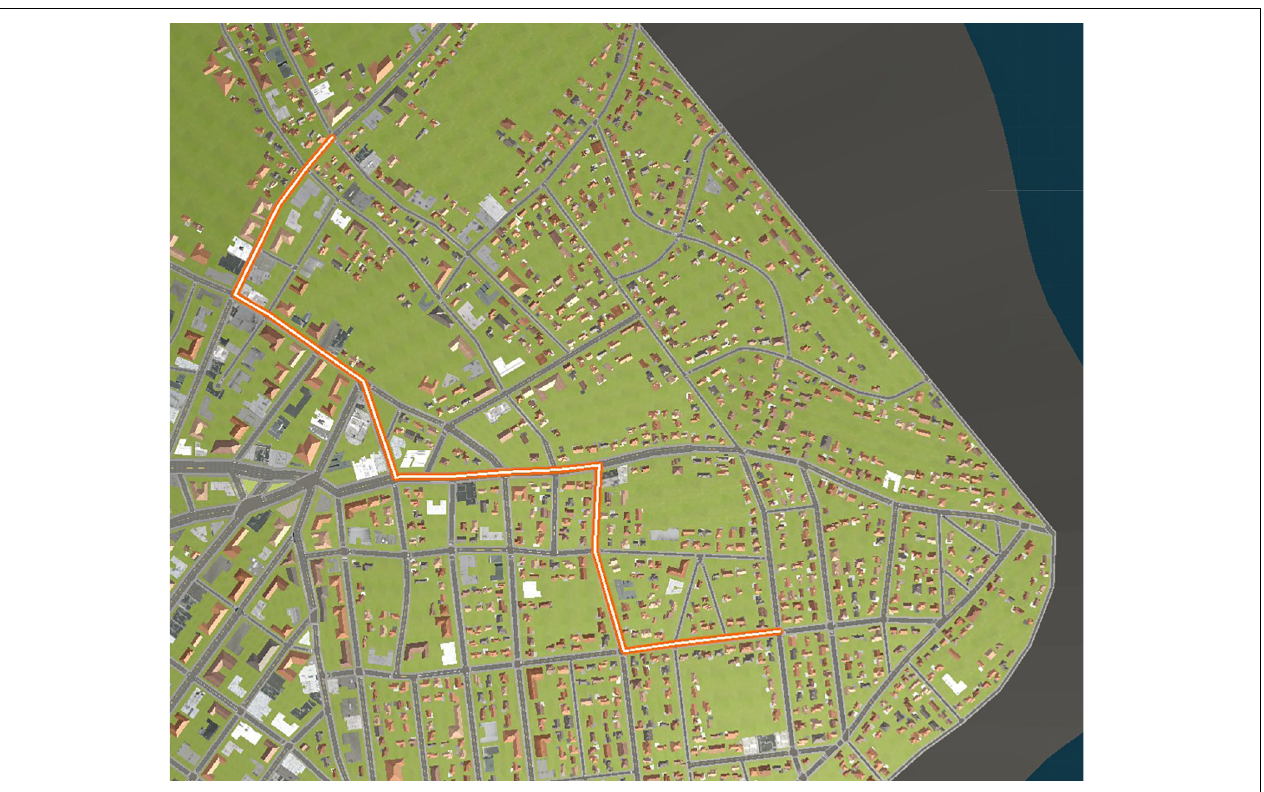
FIGURE 4 | Route B (Start in lower right of the